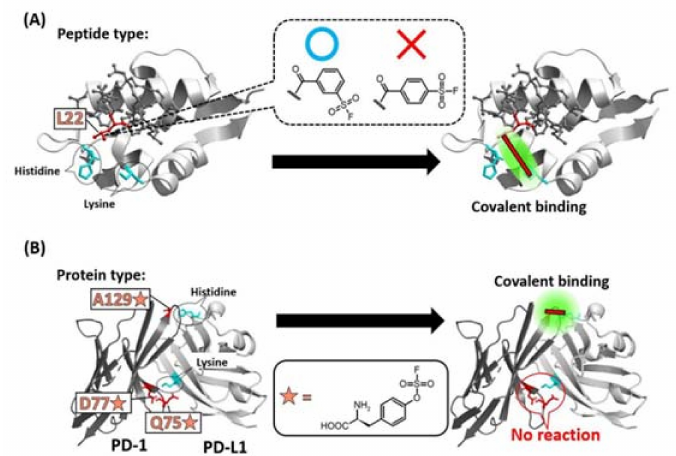
Figure 4. Specificity of the position of warhead incorporation for a successful covalent-bond formation. ( A ) SuFEx-type warhead isomers were introduced into the 22nd leucine (L22) position of a Mdm2/4 (light gray) binding staple peptide (dark gray). Only meta-substituted regioisomer reacted with a lysine of Mdm2/4. ( B ) Q75, D77, A129 of PD-1 (dark gray) was mutated into SuFEx-type Uaa (orange star). Only A129-mutated PD-1 reacted with a histidine on PD-L1 (light